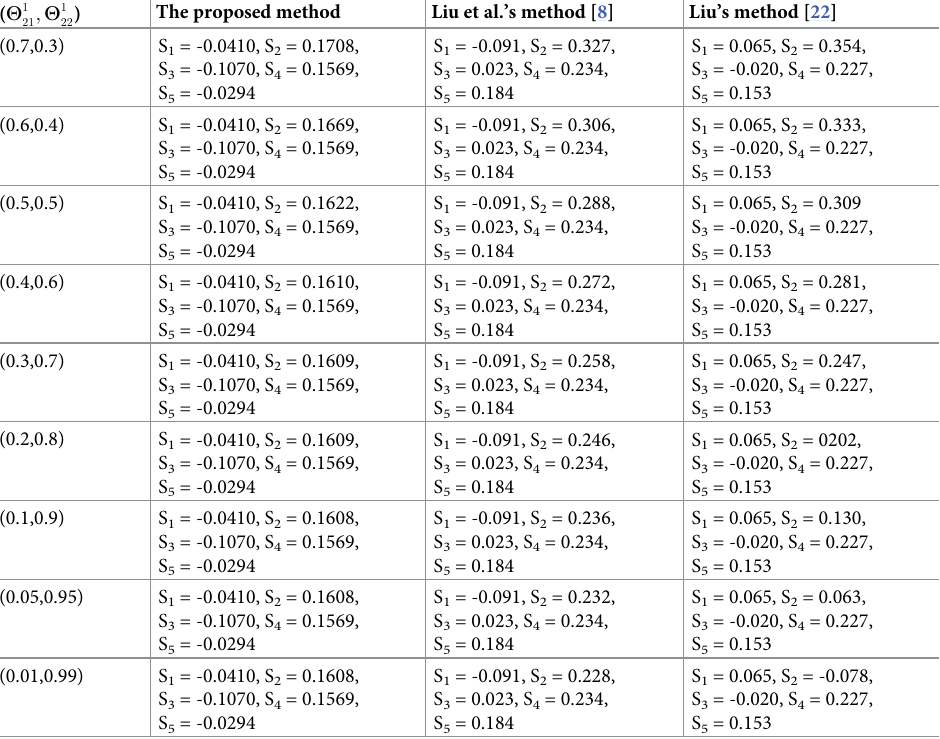
Table 12. The scores of the three methods.